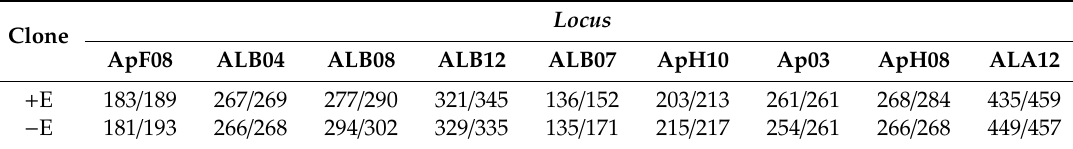
Table 1. The multilocus genotypes of the − E and + E clones of Acyrthosiphon pisum . The numbers represent the allele sizes (in